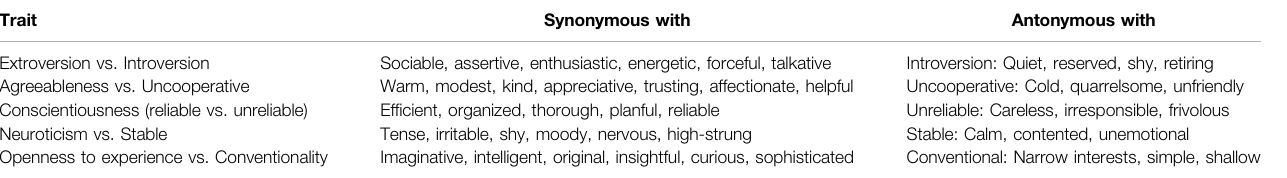
TABLE 1 | Table displaying synonyms and antonyms for the Big Five personality traits based on John and Srivastava (1999). Trait Synonymous with Antonymous